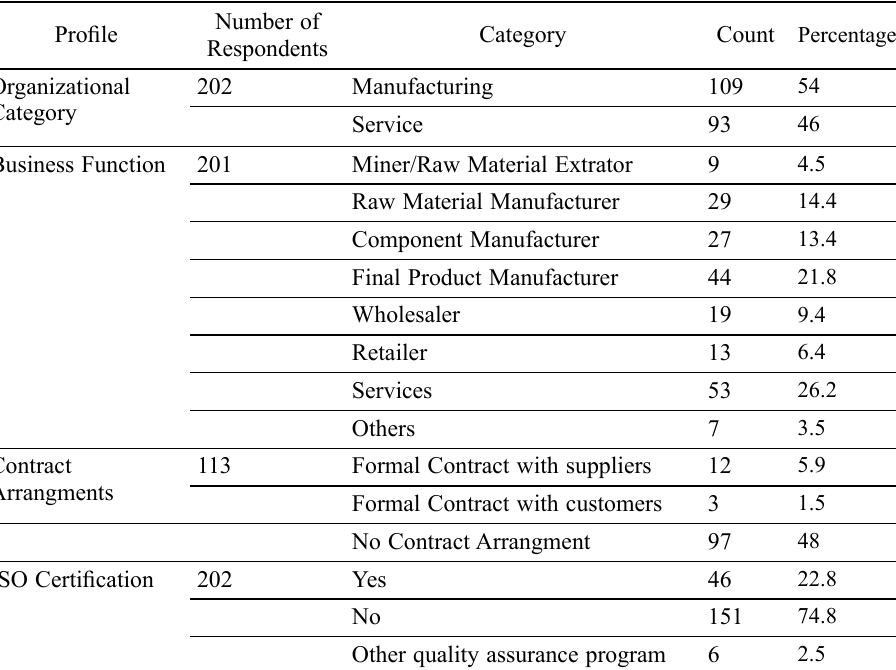
Table 2. Profile of the responding